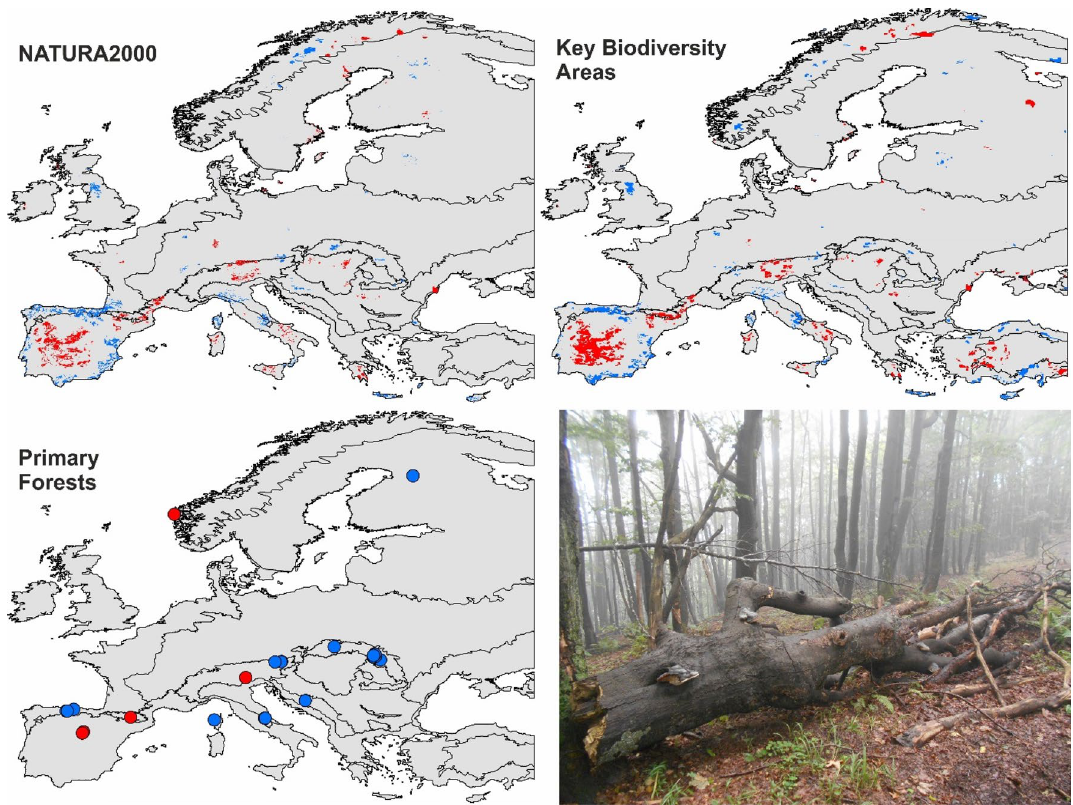
Figure 4. Geographical coverage of existing biodiversity conservation within areas of low (blue) or high (red) regional-scale climate stability persisting throughout the twenty-first century. Maps were created in ArcGIS Desktop v. 10.7 (Esri, California, USA). The final layout was created in ArcGIS Desktop v. 10.7 (Esri, California, USA) and CorelDraw v. 20.1.0.707 (2018 Corel Corp.). The photo illustrates a primary beech forest in the Western Carpathians, Kremnické Mts., Slovakia. Credit: Merganičová, K.